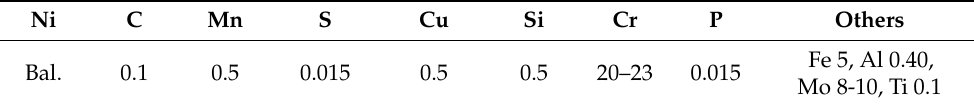
Table 1. Nominal composition of Inconel 625 (wt.%).